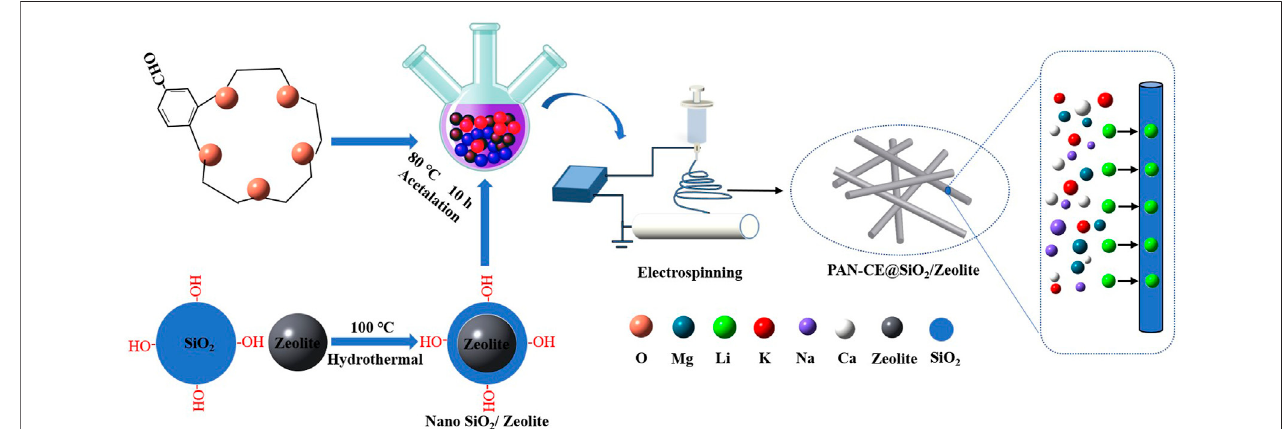
FIGURE 1 | Synthetic route of the PAN-CE@SiO 2